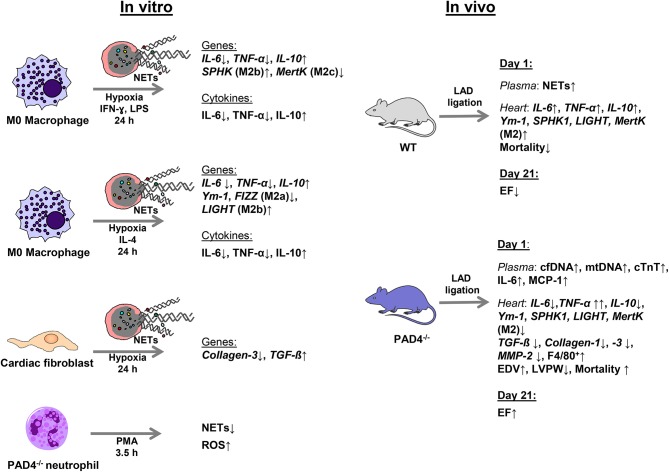
Schematic summary of the experimental design and main results.